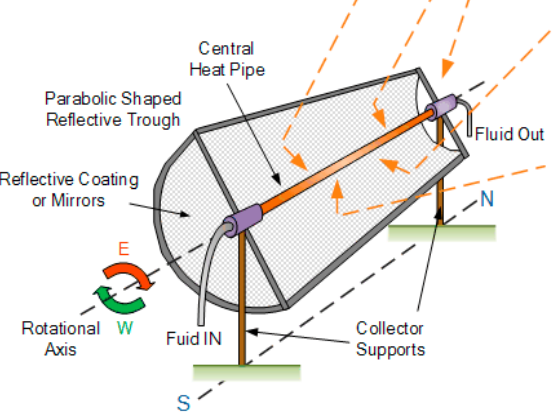
Figure 2. General conceptual form of a parabolic trough collector (PTC) [23].